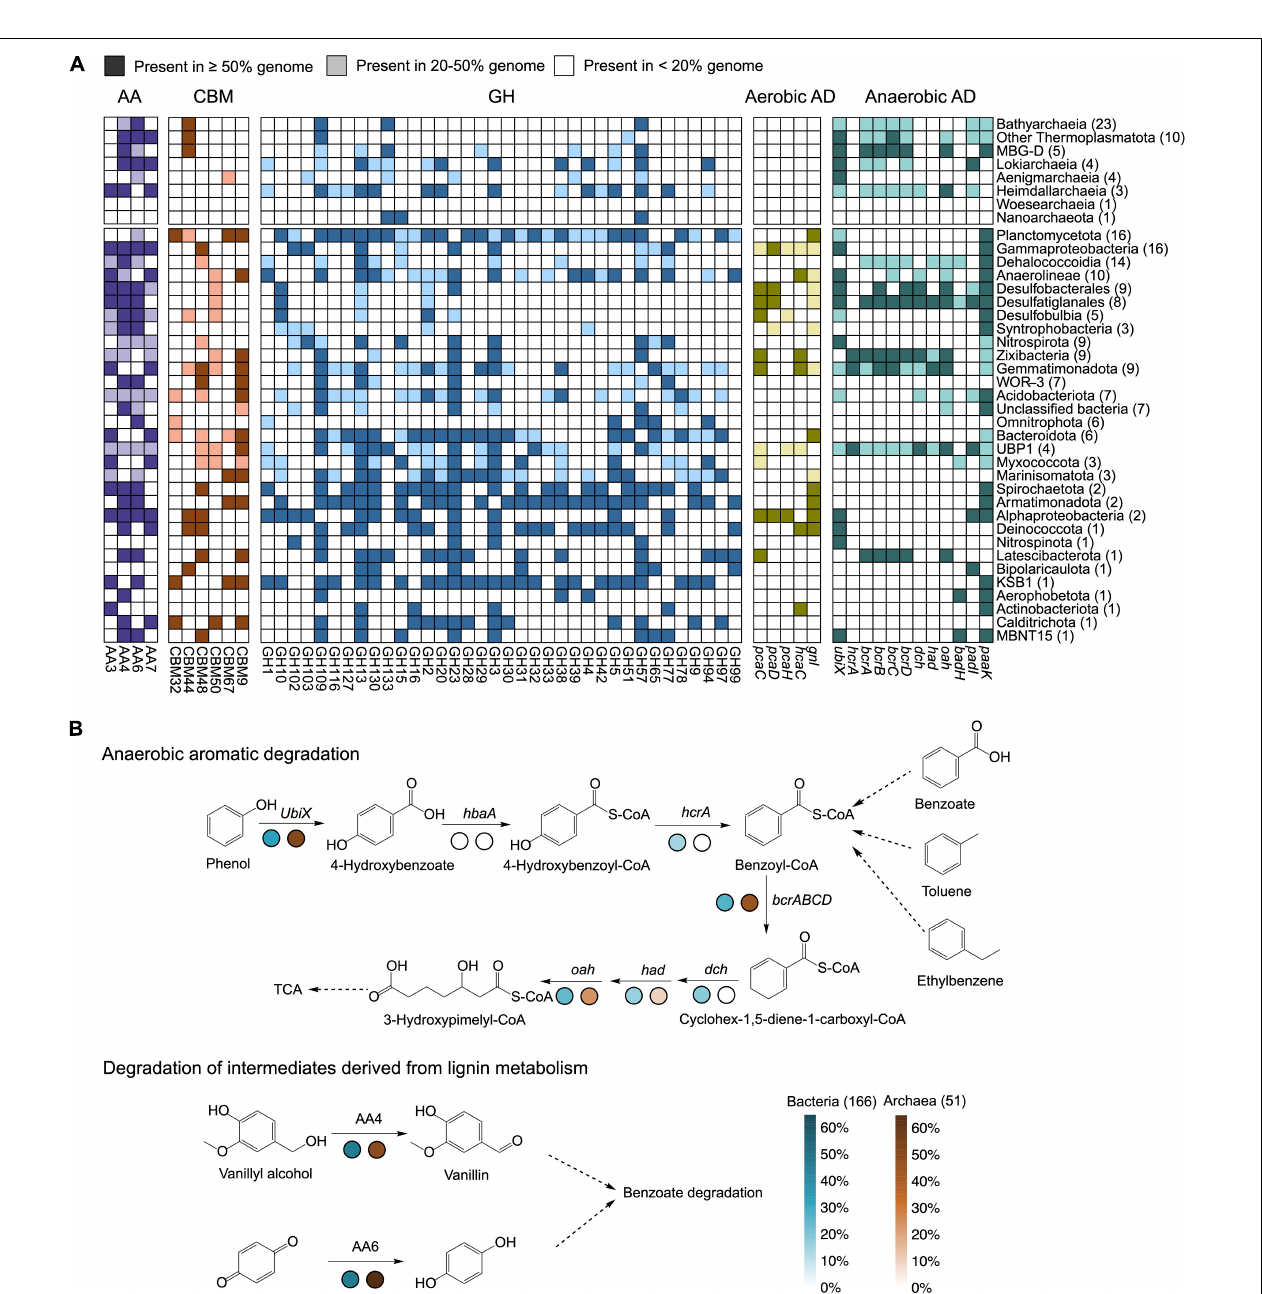
FIGURE 6 | Metabolic potential involved in organic degradation of genomes. (A) Percentage of carbohydrate-active enzymes (CAZymes) and aromatic degradation genes encoded in genomes summarized for each cluster. Each group of enzymes were set as the same color codes strategies. Brackets: Total number of genomes in each phylogenetic cluster. AA, auxiliary activities; CBM, cellulose-binding motifs; GH, glycosyl-hydrolases; Aerobic AD, aerobic aromatic degradation; Anaerobic AD, anaerobic aromatic degradation. (B) Reconstructed anaerobic aromatic degradation pathway and reactions participating in lignin degradation. Percentage of genes were summarized for archaea and bacteria. Brackets: Total number of genomes in each domain.